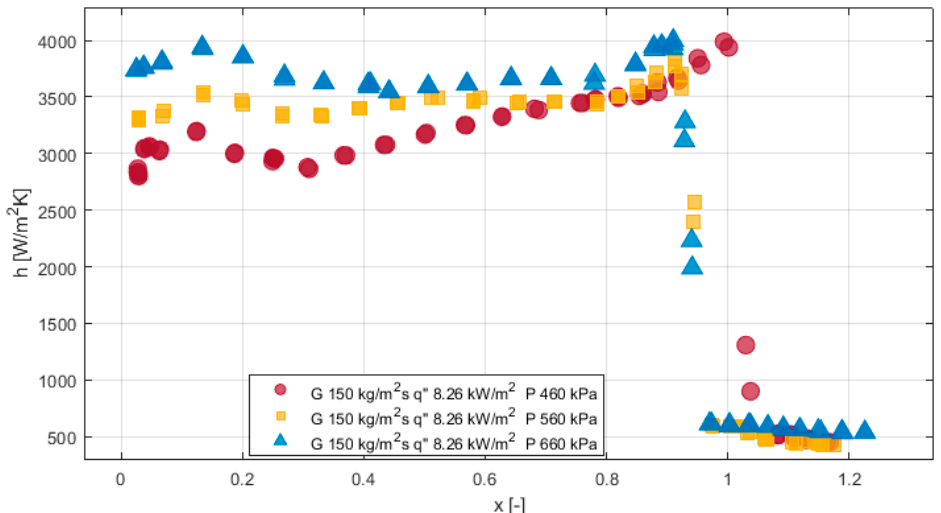
Figure 5. Effect of saturation pressure on heat transfer coefficient for mass flux 150 kg/m 2 s and heat flux of 8.26 kW/m 2 .